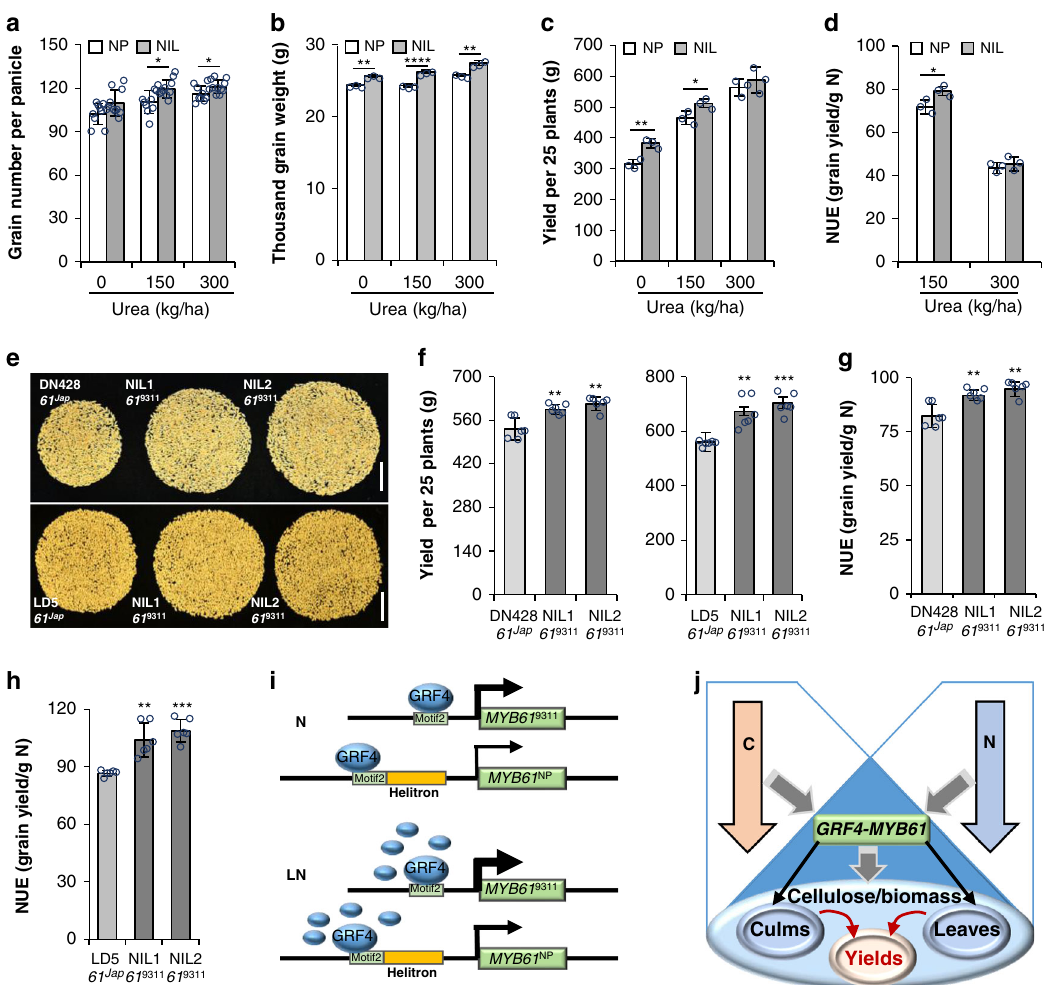
Fig. 6 The 9311 allele of MYB61 shows enhanced NUE and grain yield. a , b Measurement of the agronomic traits of NP and the NIL growing in the fi elds under different urea conditions. Error bars indicate the mean ± SD of 10 plants in ( a ) and three biological replicates in ( b ). c Grain yield of 25 plants of NP and the NIL growing under the indicated urea supply. Error bars indicate the mean ± SD of three biological replicates. d NUE of NP and the NIL growing under the indicated urea condition. Error bars indicate the mean ± SD of three biological replicates. e Grains per plant of the recipient varieties and the NILs growing under 150 kg/ha urea condition. Bar = 5 cm. n = 3 biologically independent plants. f Grain yield of 25 plants of the recipient varieties and the NILs growing under 150 kg/ha urea condition. Error bars indicate the mean ± SD of six biological replicates. g , h NUE of the recipient varieties and the NILs growing under 150 kg/ha urea condition. Error bars indicate the mean ± SD of six biological replicates. i The working model of GRF4-regulated MYB61 . GRF4 binds to MYB61 promoter region; however, the helitron element insertion compromises GRF4 binding and transactivation activity. Low nitrogen triggers GRF4 accumulation, which enhances MYB61 transcription. The expression level of MYB61 is proportional to the thickness of arrows. j The metabolic fl uxes mediated by GRF4 and MYB61. The GRF4-MYB61 model coordinates C&N metabolism, which promotes cellulosic biomass production and grain yield. Statistical signi fi cance in this fi gure was calculated with two-tailed Welch ’ s unpaired t -test and p values are indicated (* p < 0.05, ** p <